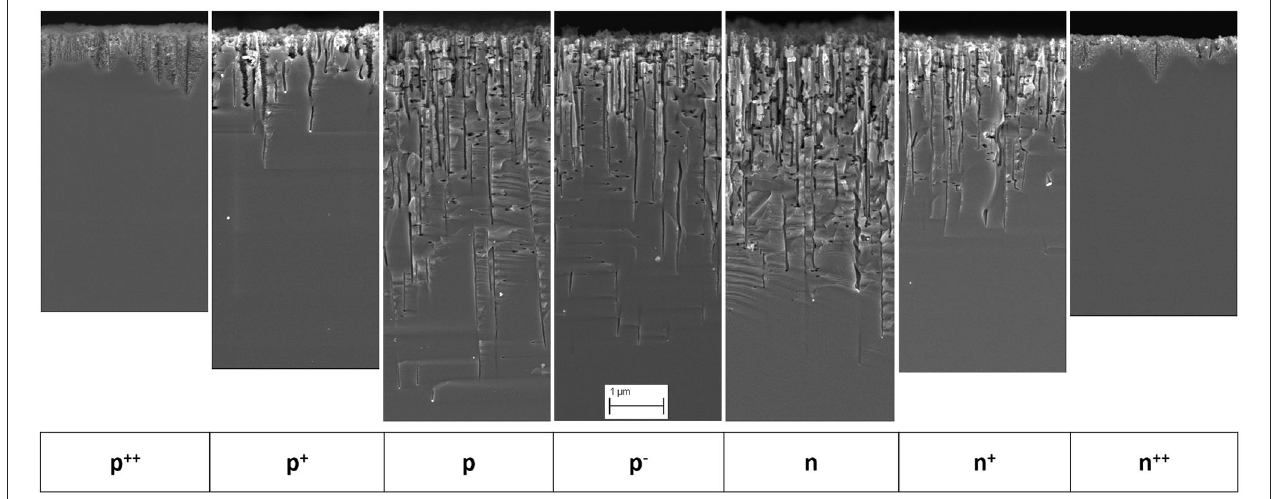
FIGURE 1 | SEM images of mesopore tips formed by MACE with silver nanoparticles and HF-H 2 O 2 in silicon substrates with doping levels: p ++ , p + , p, p − , n, n + , n ++ . Same magnification for all images. Scale bar: 1 µ m.